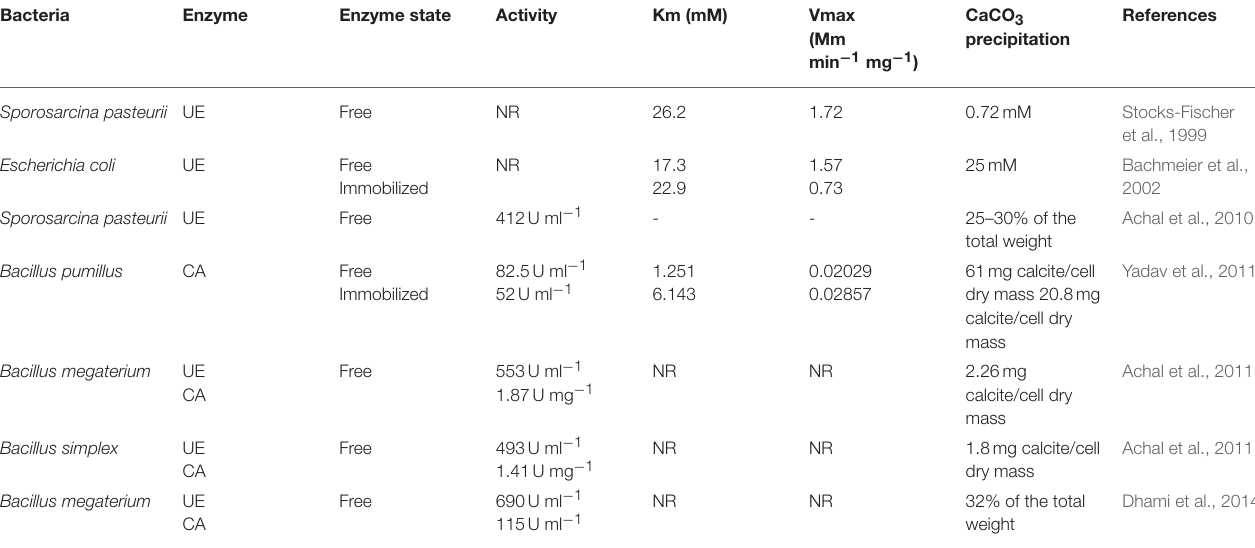
TABLE 2 | Urease and carbonic anhydrase activity, Km, Vmax, and CaCO 3 precipitation of free and immobilized systems. Bacteria